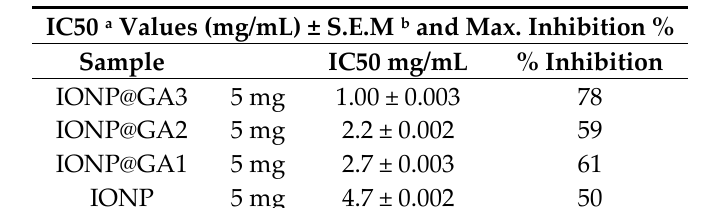
Figure 8. UV ‐ VIS spectra. Table 4. IC50 of